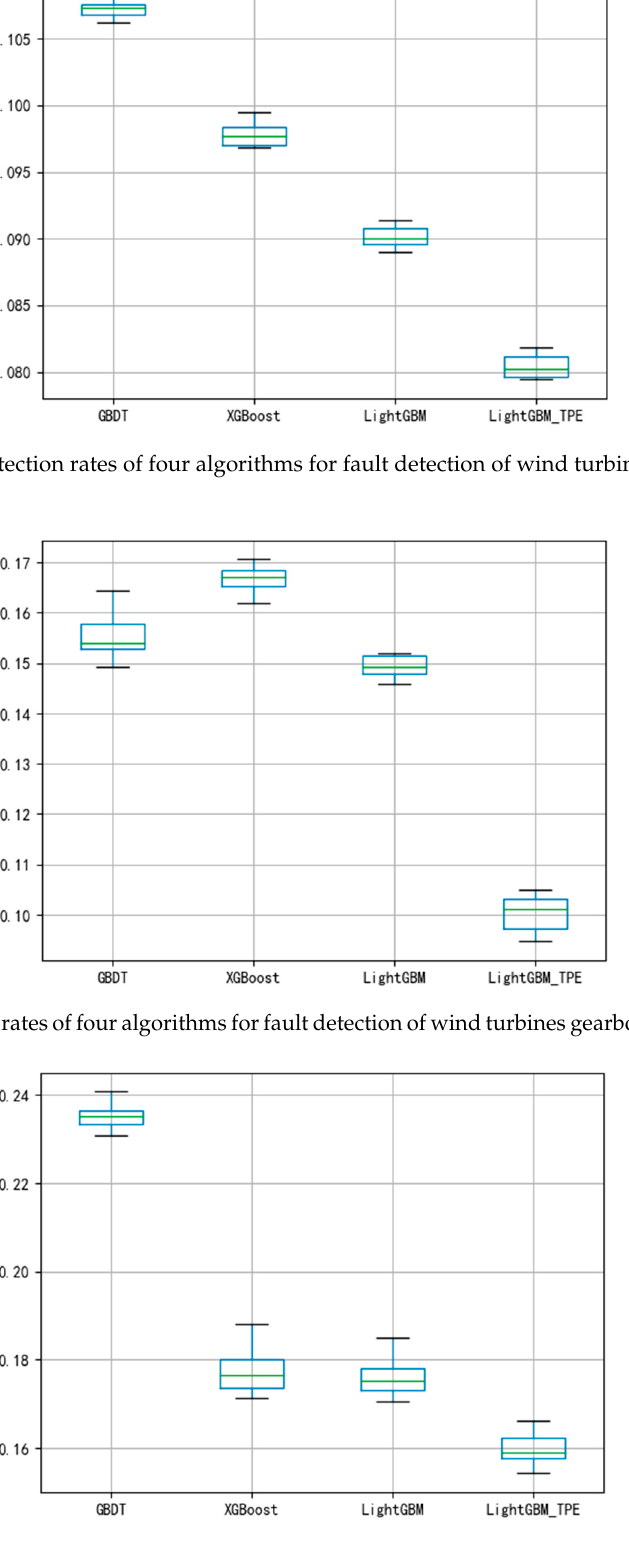
Figure 9. Missing detection rates of four algorithms for fault detection of wind turbines gearboxes on dataset